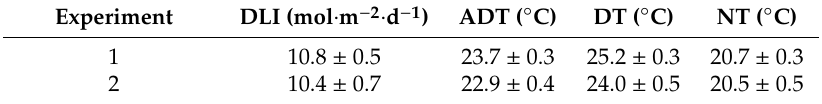
Table 1. Mean ( ± standard deviation) daily light integral (DLI), average daily air temperature (ADT), and average day (DT) and night (NT) air temperature for parsley and sage (Expt. 1) or basil and dill (Expt. 2) grown in 11.4 cm diameter containers filled with a soilless substrate comprising (by vol.) 75% sphagnum peat moss and 25% coarse perlite amended with 3.0 kg · m − 3 and maintained at 0.15,